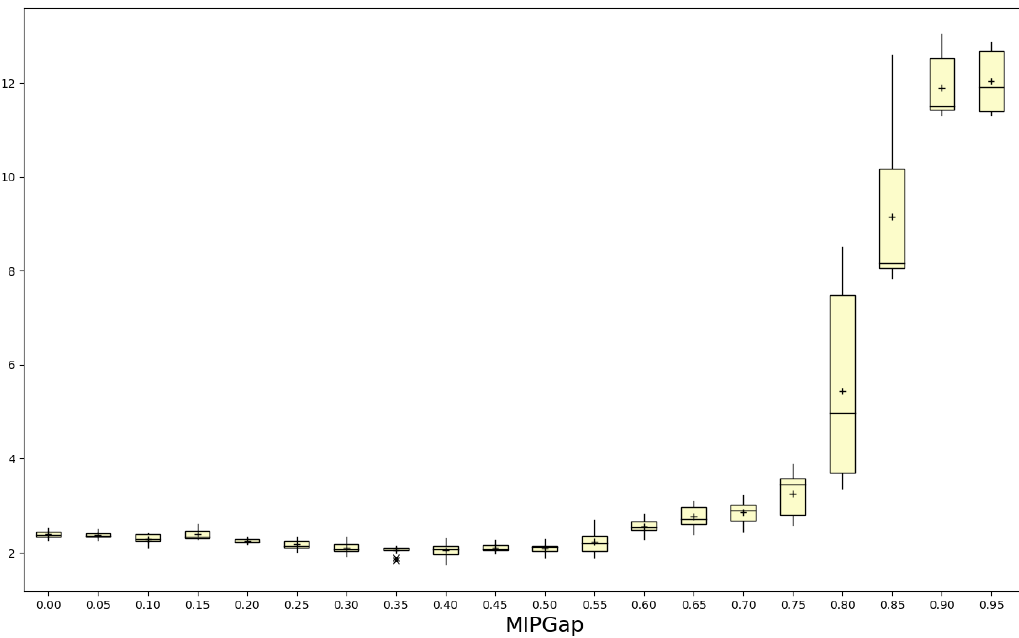
Figure 3. Boxplot comparison of instance 1 results with different MIPGap